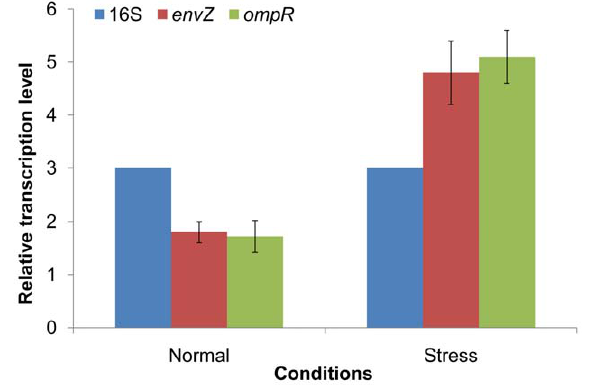
Figure 3. Motility of the D envZ , D ompR , D envZ D ompR mutants. Both swimming and swarming motility assays were performed. The parental wild type and an aflagellated strain were included as controls. Experiments were performed five times and results were statistically consistent ( p , 0.05). Only swimming results were shown as swimming and swarming are in agreement with each other.